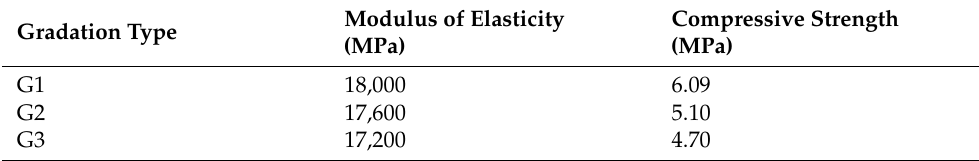
Table 2. Effect of gradation type on performance properties of semi-flexible pavement